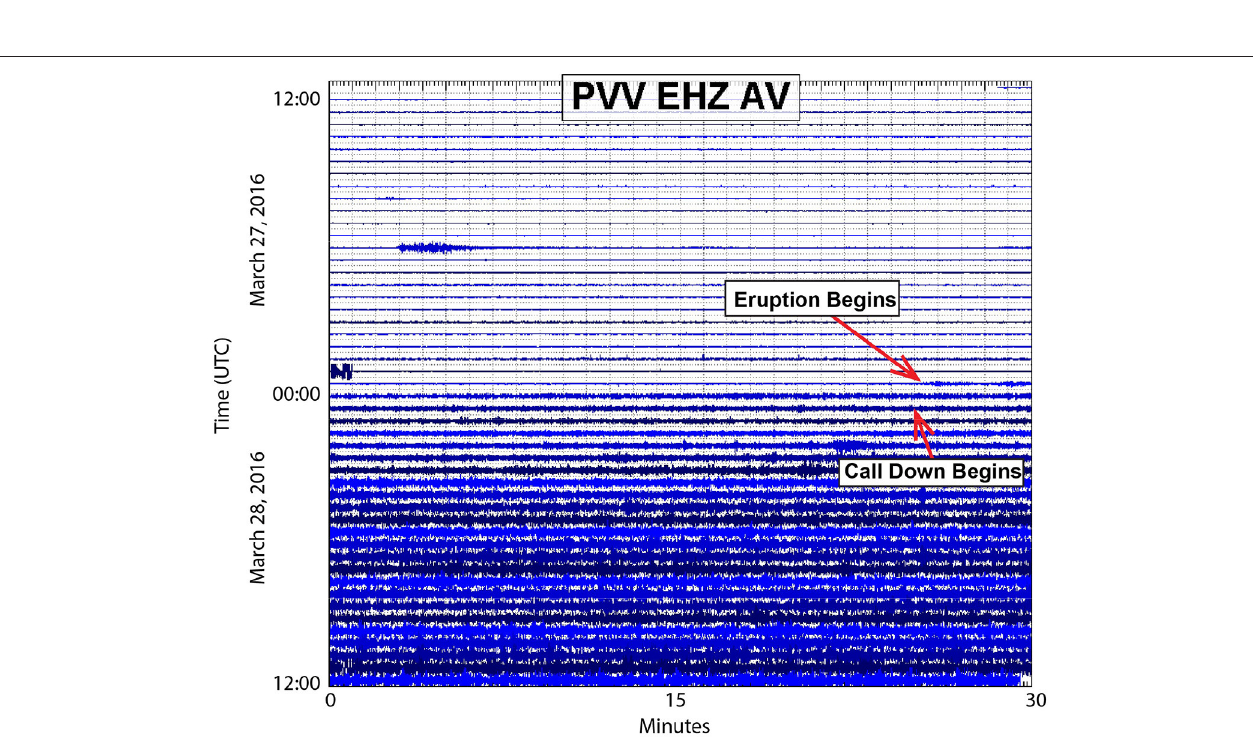
FIGURE 7 | A 24-h velocity seismic record from station PVV that shows the onset of the 2016 eruption of Pavlof Volcano. The eruption began with the subtle increase in volcanic tremor at 23:55 on March 27 and the AVO call down occurred at 00:55 on March 28.